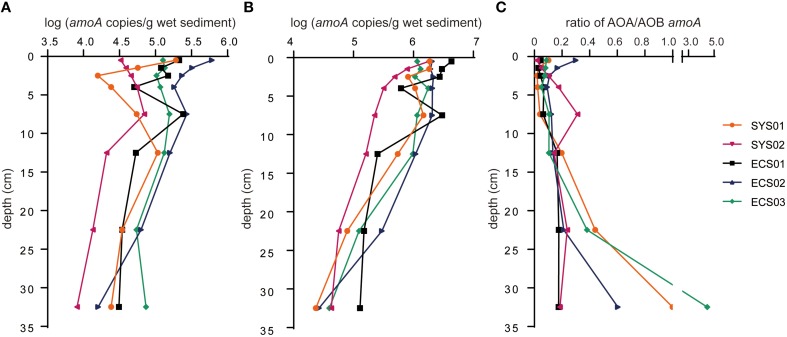
Quantitative analysis of amoA for AOA and AOB in mud deposits of the eastern China marginal seas. (A), AOA; (B), AOB; (C), ratio of archaeal to bacterial amoA. Error bars represent standard deviations of triplicate analyses. -0, -1, -2, -3, -5, -10, -20, and -30 represent samples at the depth of 0–1, 1–2, 2–3, 3–5, 7–8, 12–13, 22–23, and 32–33 cm, respectively.